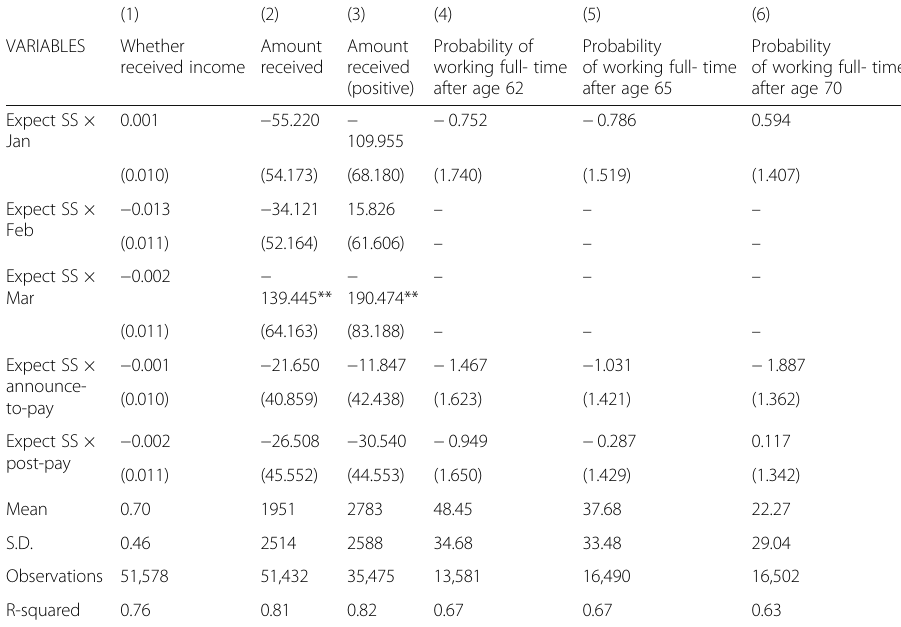
Probability of working full- time after age 65